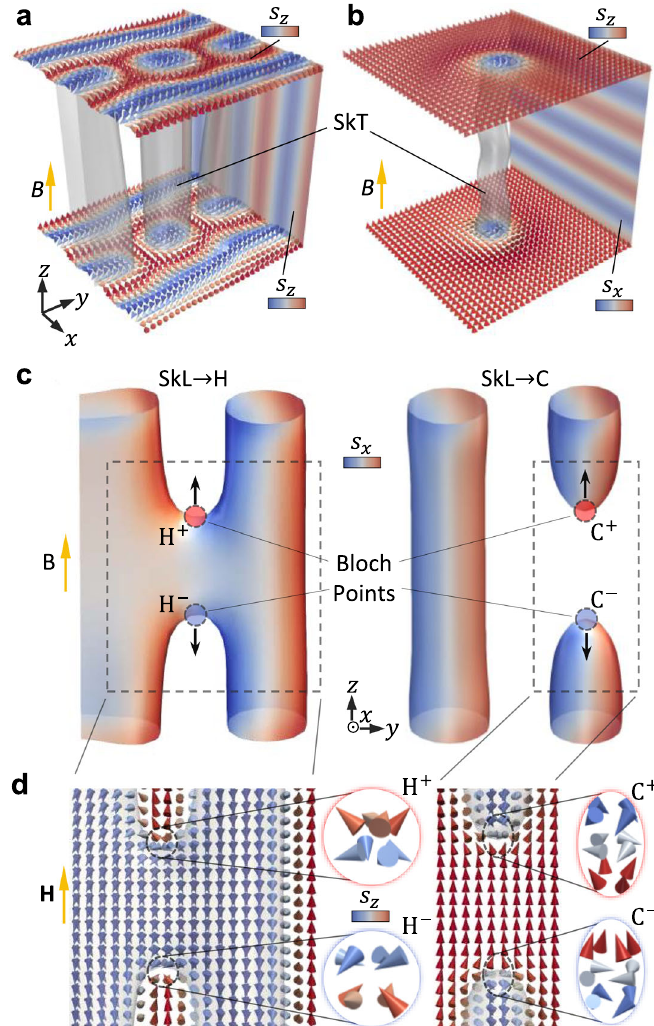
Fig. 1 Bloch-point-mediated skyrmion annihilation mechanisms. a , b Three-dimensional visualisations of simulations display a skyrmion tube (SkT) embedded in the helical and conical states respectively. The grey contours highlight regions where the magnetisation along the z -axis, s z = 0. The top and bottom layers of spins have been coloured according to their s z component. The back right surface of each simulation has been coloured according to the local s z or s x components respectively, highlighting the orientation of the surrounding helical and conical structures. c Visualisations of the skyrmion to helical (SkL → H), and skyrmion to conical (SkL → C) annihilation mechanisms, where the contour surfaces highlight regions where s z = 0, and the colouration indicates the local s x component. A pair of Bloch points is nucleated where either the SkT connects to the local helical structure (left, H + and H − ), or breaks in two to form the conical state (right, C + and C − ). d Cross-sections of the spin texture around the Bloch-point structures shown in c. Insets display the local spin arrangement around each Bloch point. Colours indicate the m z Fig. 3a (full dataset shown in Supplementary Fig. S4 and Sup- plementary Note 4). Here, the AC susceptibility has been nor- Þ , where χ malised, χ 0 N ¼ ð χ 0 f (cid:2) χ 0 ð t ÞÞ = ð χ 0 f (cid:2) χ 0 0 is the initial value 0 of χ 0 at t = 0, and χ f is the value the system is tending to as t → ∞ . The lifetime of the metastable skyrmion state at each fi eld, τ , was extracted by fi tting the data to a stretched exponential decay function 46 ,